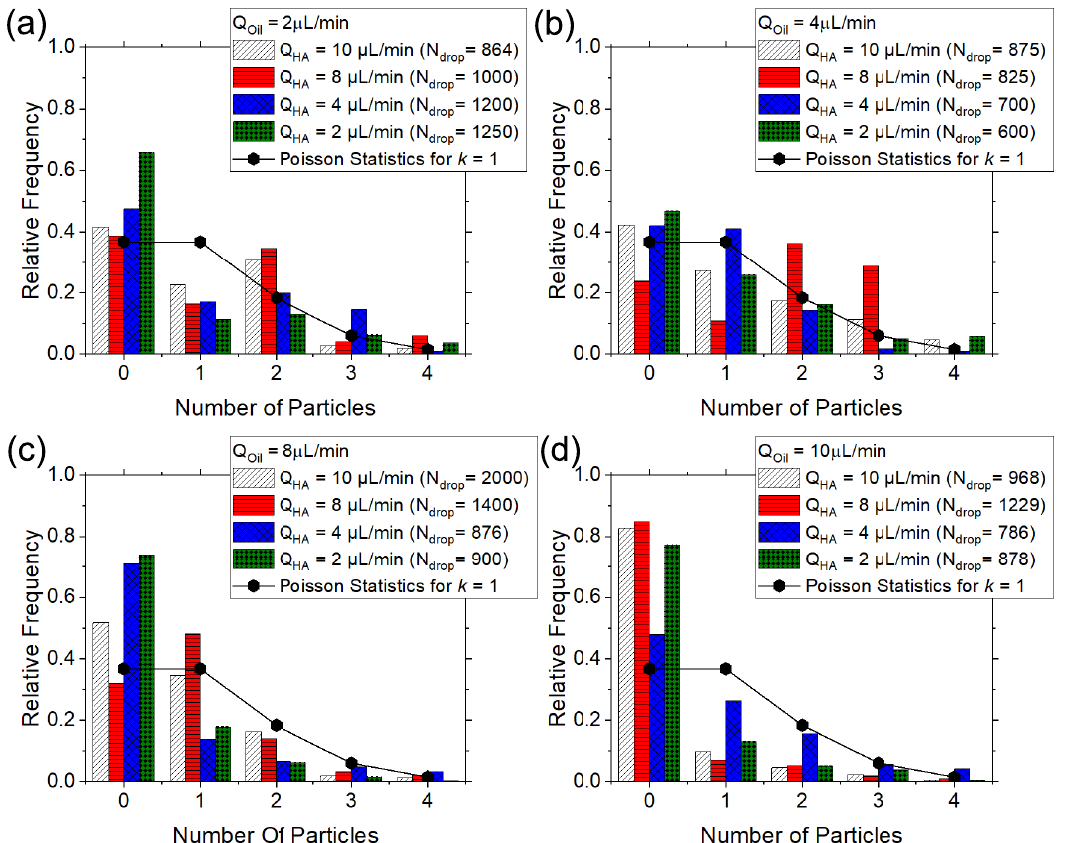
Figure 3. Viscoelastic particle encapsulation for a hyaluronic acid (HA) dispersed phase and a mineral oil continuous phase. ( a – d ) Histograms of relative frequency as a function of particles per droplet for a fixed oil flow rate Q oil . For each fixed Q oil value, the flow rate of the HA Q HA was in the range 2 to 10 µ L/min. The Poisson statistics value obtained for k = n = 1 is represented by the solid symbols. A single particle encapsulation efficiency above the Poisson stochastic value is obtained for Q oil = Q HA = 4 µ L/min ( b ) and Q oil = Q HA = 8 µ L/min ( c